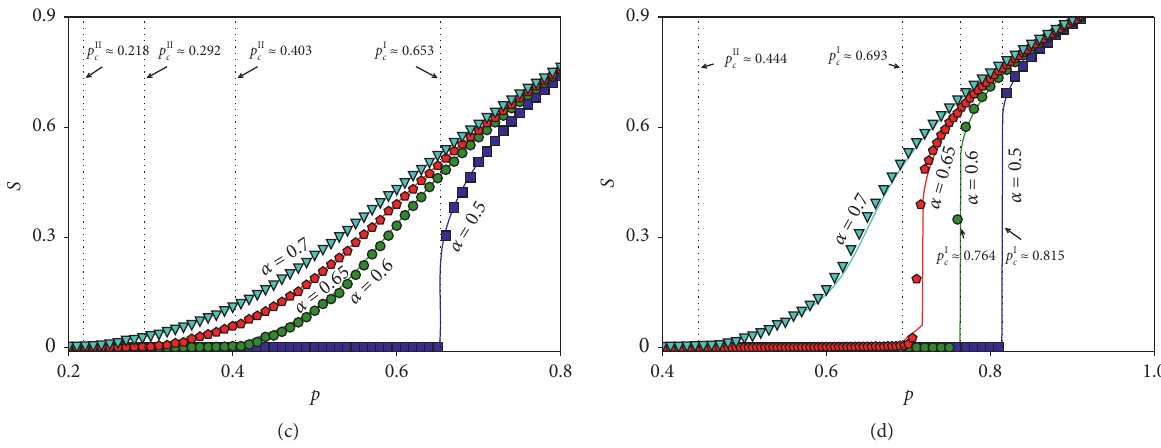
� 2, k � 63, and c � 2 . 5. min max � 2, k � 141, and c � 2 . 3. The simulation results were obtained by min max